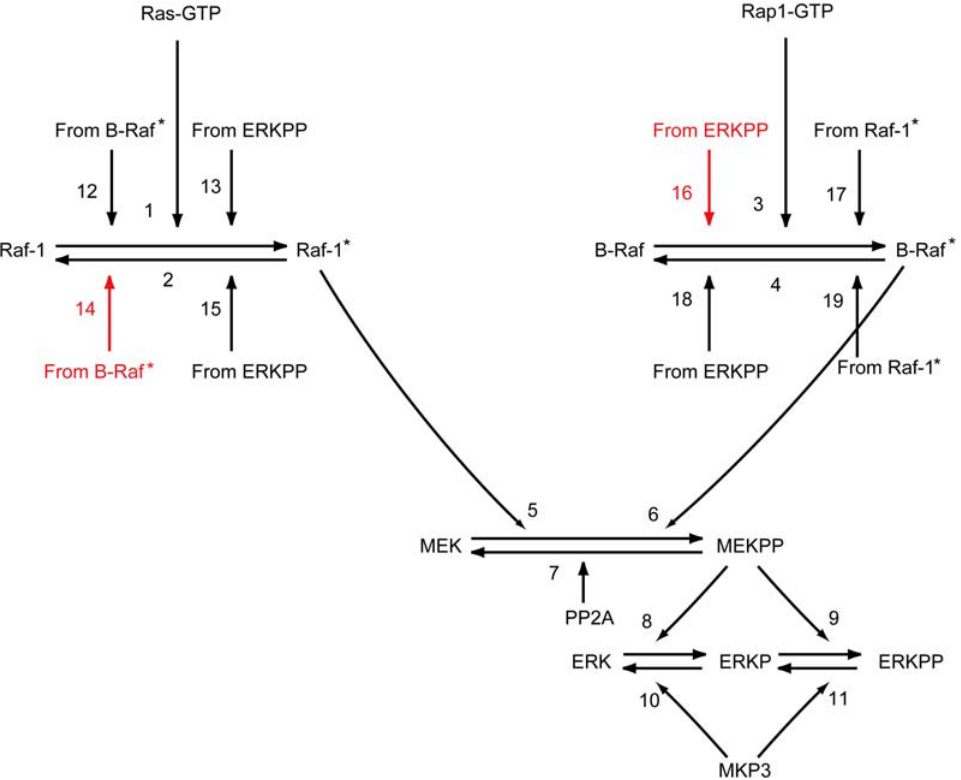
Figure 2. Topological model of the Raf-MEK-ERK cascade in CHO cells. The inputs of the Raf-MEK-ERK cascade are the activated forms of Ras and Rap1, Ras-GTP and Rap1-GTP. The output is the doubly phosphorylated ERK, ERKPP. Steps 1–11 are the fixed part of the cascade, whereas steps 12–19 are possible cross-talk/feedback connections to be determined. The selected pathways were steps 14 and 16 (red arrows). Numbers shown correspond to the kinetic equations in Table